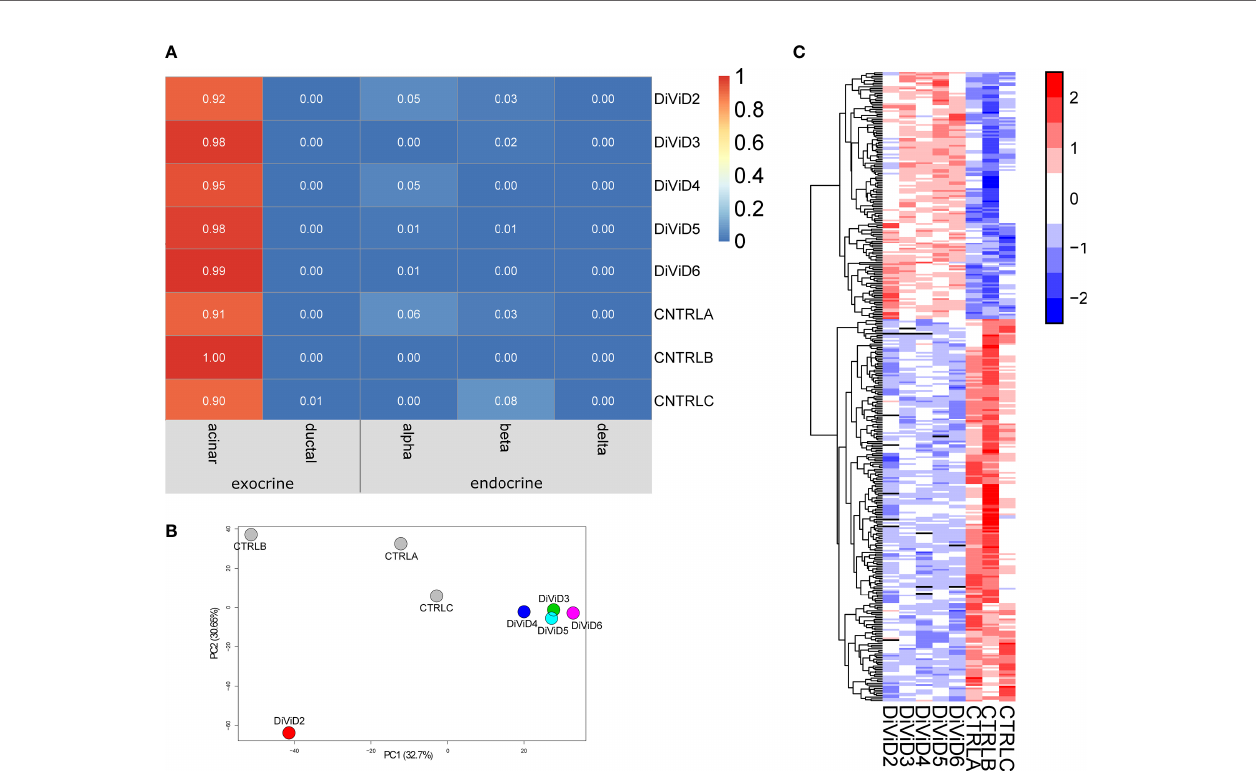
FIGURE 1 | The whole pancreas tissue transcriptome 1. (A) Estimated cell type proportions in the pancreatic tissue samples. The online deconvolution tool CIBERSORT (28) was utilized to obtain the estimates. (B) Samples of the data along the fi rst two principal components. (C) The z-score standardized expression of the differentially expressed genes in the data. The differentially expressed genes were identi fi ed using the reproducibility optimized test statistic (ROTS) (30) with a false discovery rate of ≤ 0.05 and a fold change of ≥ 2. In all panels, CTRLA refers to the Agilent commercial control (non-diabetic organ donor), CTRLB refers to the Ambion commercial control (non-diabetic organ donor) and CTRLC refers to the commercial Clontech control (non-diabetic organ